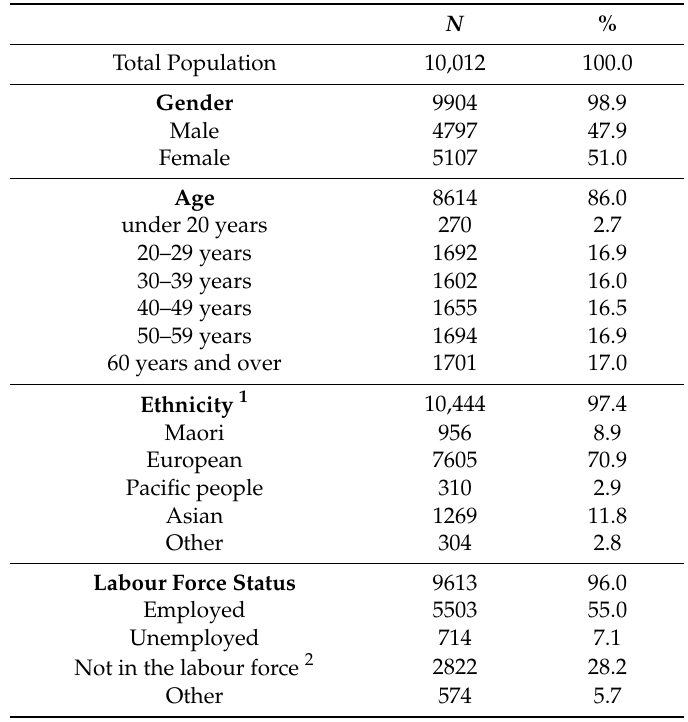
Table 2. Demographic data of respondents 1 to the Sovereign Wellbeing Index,